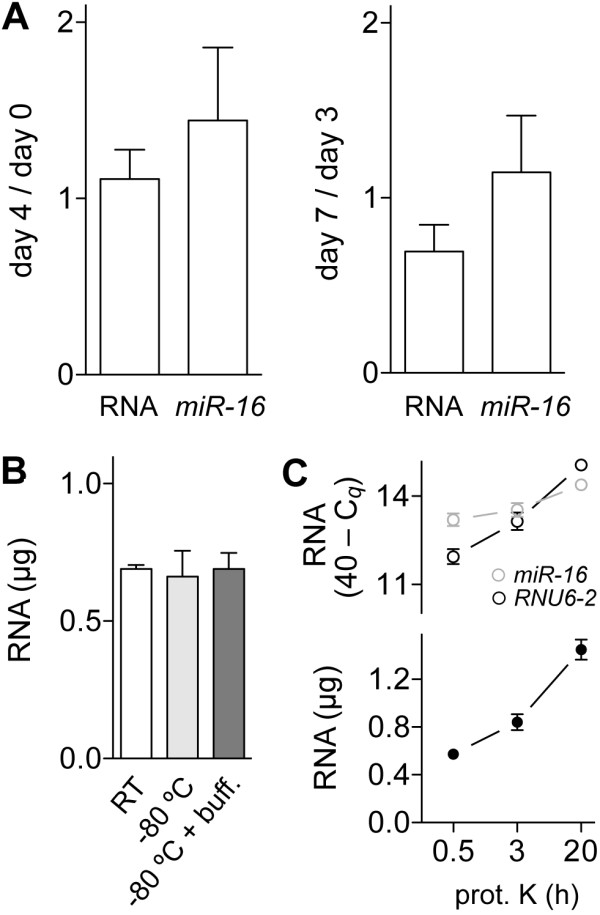
Effect of age of slides and dissectates, and proteinase K treatment duration on RNA yield. A. Total RNA and miR-16 yields from laser microdissectates from three tissues prepared from four or seven day-old slides relative to zero or three day-old ones, respectively. B. Total RNA yield from identical laser dissectates from zero day-old slides stored in duplicate at room temperature (RT), or at -80°C with or without buffer (buff.) for a day. C. Total RNA yield (filled circles) and levels of RNU6-2 (black empty circles) and miR-16 (grey empty circles) from identical dissectates treated in triplicate with proteinase K (prot. K) for 0.5, 3 or 20 h. Means and their standard errors are plotted. Log2-transformed RNU6-2 and miR-16 levels were determined from quantification cycle (Cq) values obtained in reverse transcription-PCR assays. Total RNA was quantified by RiboGreen assay. Hematoxylin and eosin was used as the histologic stain, and silicon carbide columns were used for RNA isolation.